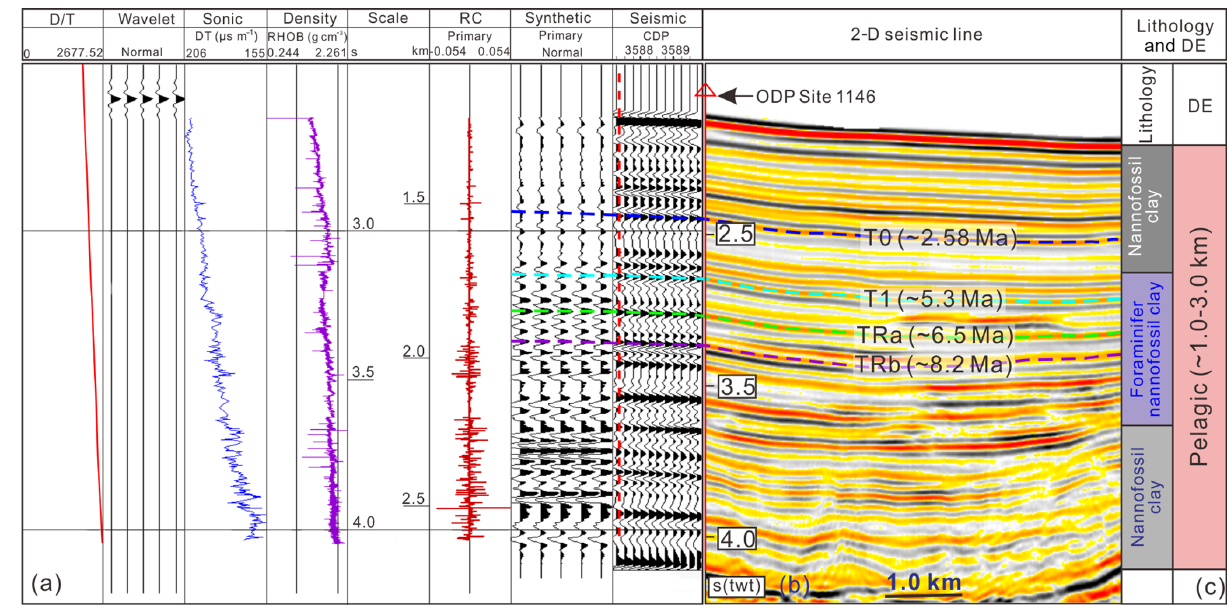
Figure 2. (a) Synthetic seismogram of ODP site 1146 (modified from Sun et al., 2017); D/T – depth/time; DT – interval transit time; RHOB – lithologic density; RC – reflection coefficient; (b) seismic profile crossing through ODP site 1146. The four seismic surfaces (T0, ∼ 2 . 58Ma; T1, ∼ 5 . 3Ma; TRa, ∼ 6 . 5Ma; and TRb, ∼ 8 . 2Ma) are labelled; (c) lithology and depositional environment (DE) of ODP site 1146 (modified from Wang et al., 2000, and Clift et al., 2001). Table 3. Dimensions of lava flow channels (C). Please note that all the lengths of lava flow channels are measured along their axes. Lava flow channels Length (km) Width (m) Thickness (m) Area (km 2 ) Volume (km 3 ) C1 2.86 a 55–273 unknown c 0.31 a unknown c Volcano edifice 1 related C2 3.66 a 94–340 unknown c 0.56 a unknown c C3 4.60 b 163–340 52 ± 13 0.84 a 0 . 044 ± 0 . 011 C4 2.80 172–229 61 ± 15 0.54 0 . 032 ± 0 . 008 C5 9.15 a 185–267 64 ± 16 1.52 d 0 . 097 ± 0 . 024 d Volcano edifice 2 related C6 6.39 203–285 60 ± 15 1.47 0 . 088 ± 0 . 022 C7 1.93 236–427 57 ± 14 0.67 0 . 037 ± 0 . 009 a Maximum lengths (including the inferred part of lava flow channels); b minimum length (C3 extends beyond the 3-D survey); c thicknesses cannot be measured because of lava flow channels (C1 and C2) are only identified on the plan-view map (RMS and variance slice map); d area and